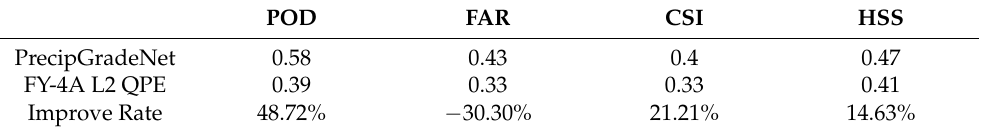
Table 8. Comparison of the effect of the PrecipGradeNet and FY-4A L2 QPE for falling area recognition during the evaluation period of 4 August 2021 to 7 October 2021, total 3,370,943 pixels.